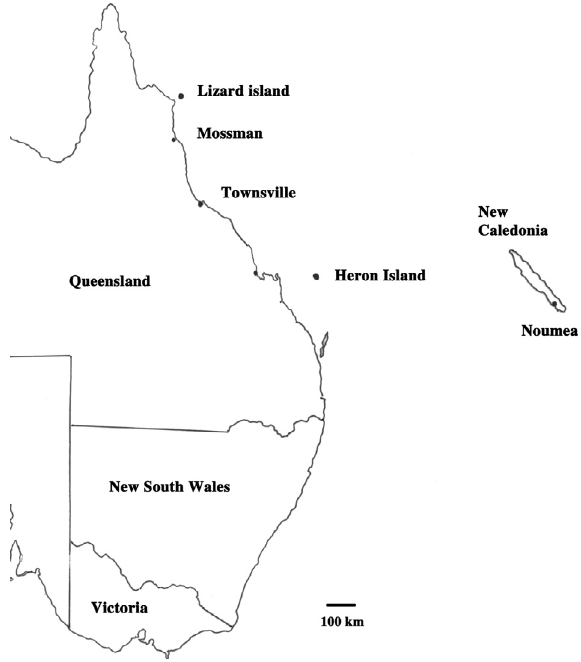
Figure 1. Collection localities off the east coast of Australia and New